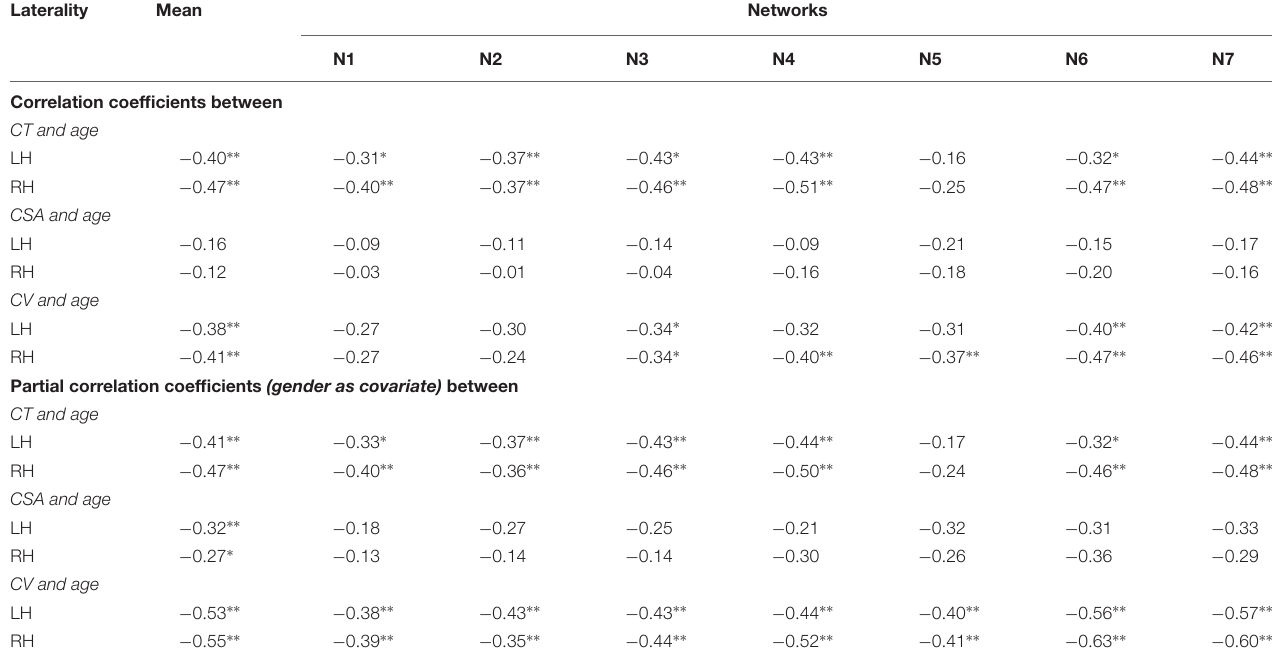
TABLE 2 | Correlation coefficients between cortical measures and